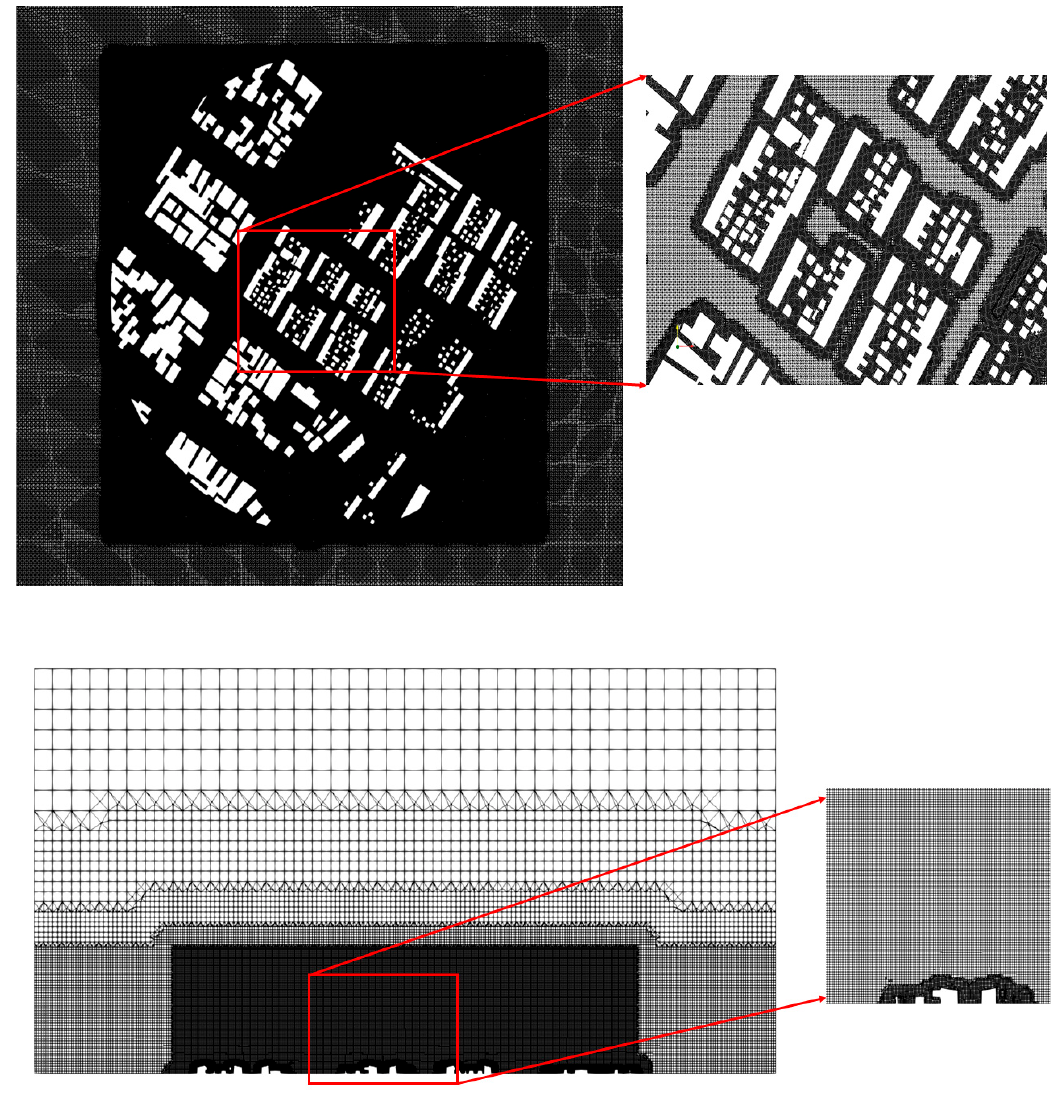
Figure 15. Mesh used for the OpenFOAM computational domain, detailing the zones used for different element sizes near the building’s walls.